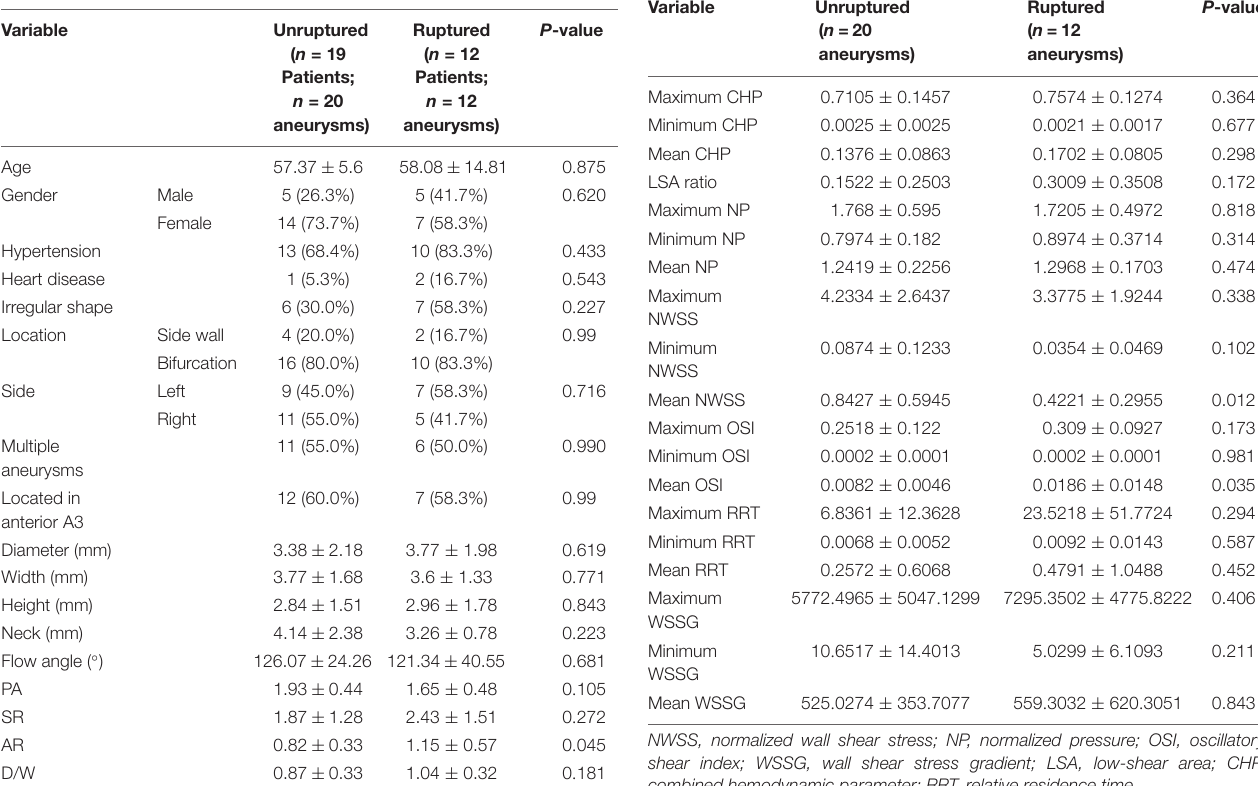
TABLE 1 | Baseline and morphological characteristics of the included patients and aneurysms.